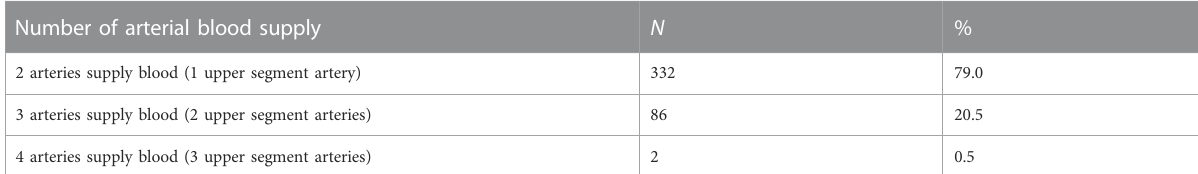
TABLE 6 The vascular characteristics of the right inferior lobar pulmonary artery.